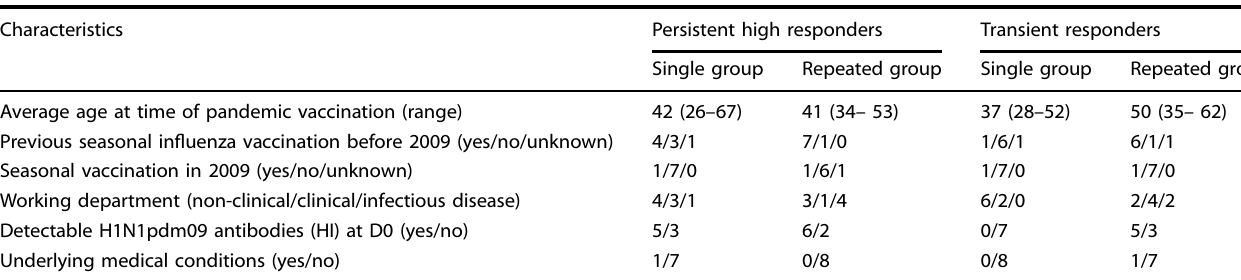
Table 1. Characteristics of study